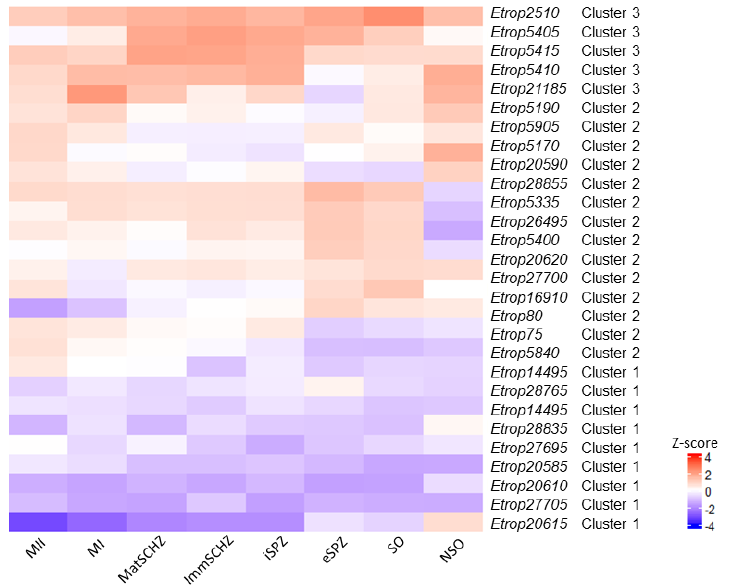
Figure 6. Heatmap of differentially transcribed rhoptry kinase genes in the Et INRAE strain. Red color indicates a rhoptry kinase transcription level higher than the mean, and blue color represents a transcription level lower than the mean. NSO non-sporulated oocysts, SO sporulated oocysts, eSPZ extracellular sporozoites, iSPZ intracellular sporozoites, ImmSCHZ immature schizonts, MatSCHZ mature schizonts, MI first-generation merozoites, and MII second-generation merozoites. The cluster resulting from the hierarchical clustering analysis are indicated.